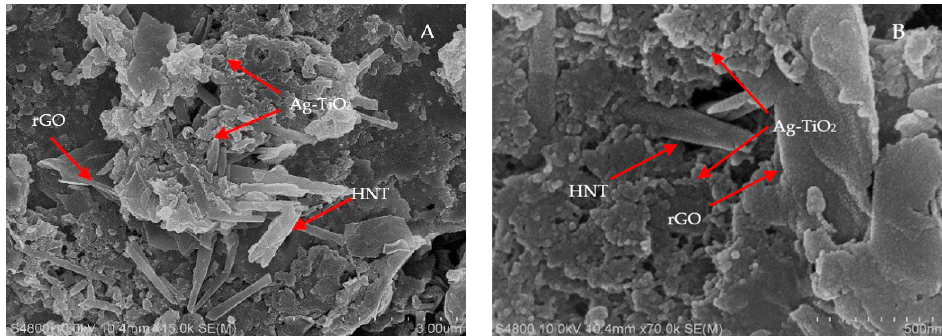
Figure 3. ( a ) N 2 adsorption–desorption isotherm of (3%)Ag-TiO 2 /rGO/HNT. ( b ) Pore size distribu- tion of (3%)Ag-TiO 2 /rGO/HNT.